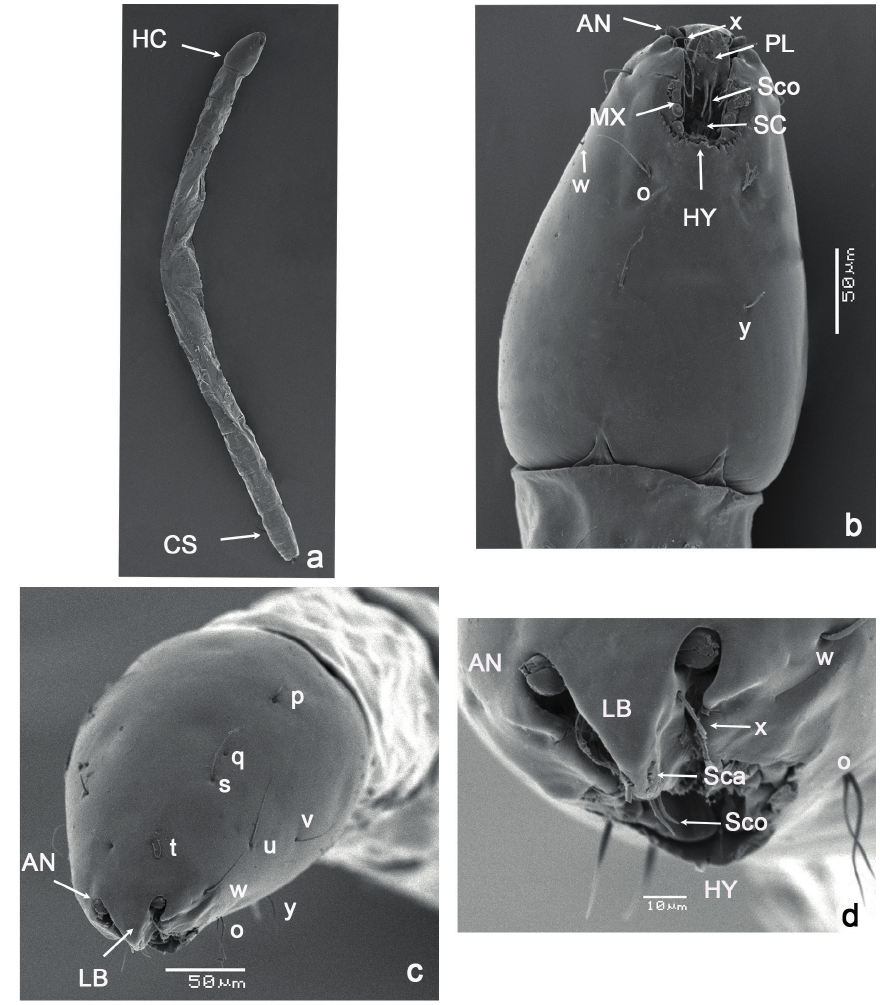
Figure 1 - Dasyhelea flavifrons Guérin-Méneville, larva (SEM). a ) entire larva (lateroventral view); b ) head capsule (chaetotaxy, ventral view); c ) head capsule (details, laterodorsal view); d ) details of labrum (frontal view). Antenna (AN); head capsule (HC); galeolacinia (gl); hypostoma (HY); labrum (lB); maxilla (MX); palatum (Pl); scopae (SC); sensilla campaniformia (Sca); sensilla coeloconica (Sco). Head capsule chaetotaxy: o, parahypostomal setae; “q”, postfrontal setae; s, anterior perifrontal setae; t, prefrontal setae; v, posterolateral setae; w, anterolateral setae; x, parantennal setae; y, ventral setae.